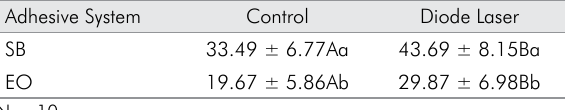
Table 3. Microtensile bond strength of dentin bonding sys- tems with or without irradiation using a diode laser [Mean (MPa) ± standard